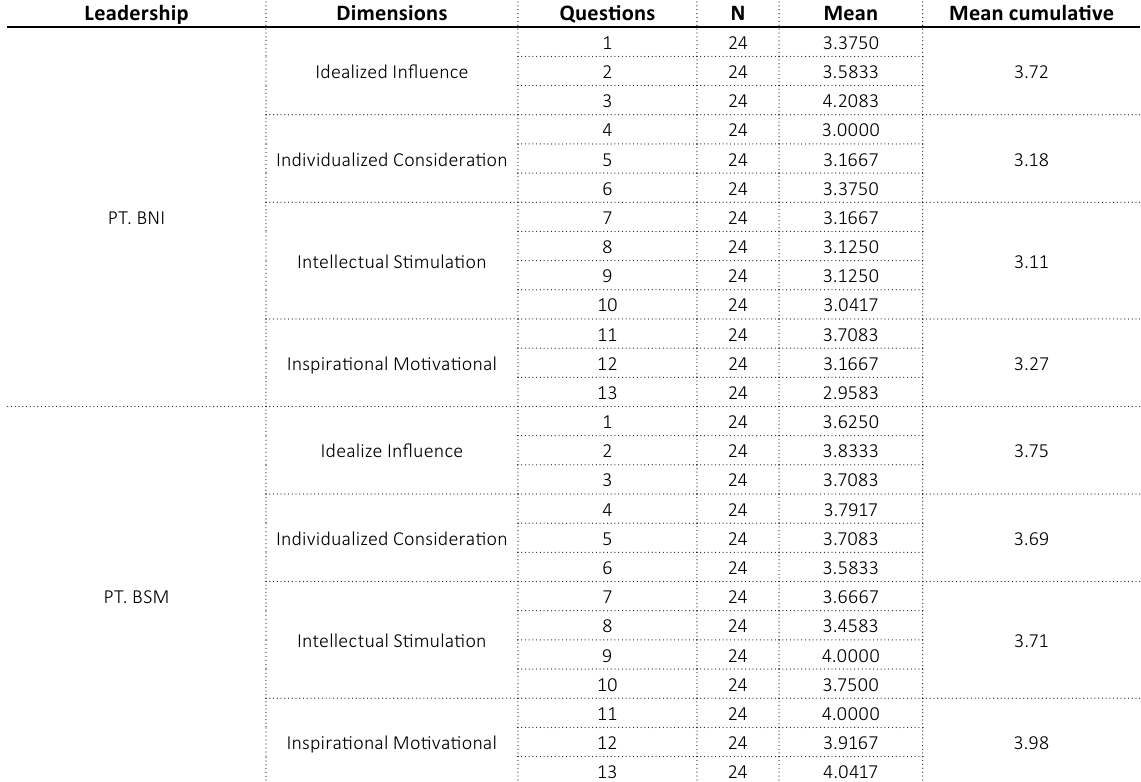
Table 2. Descriptive statistics of leadership